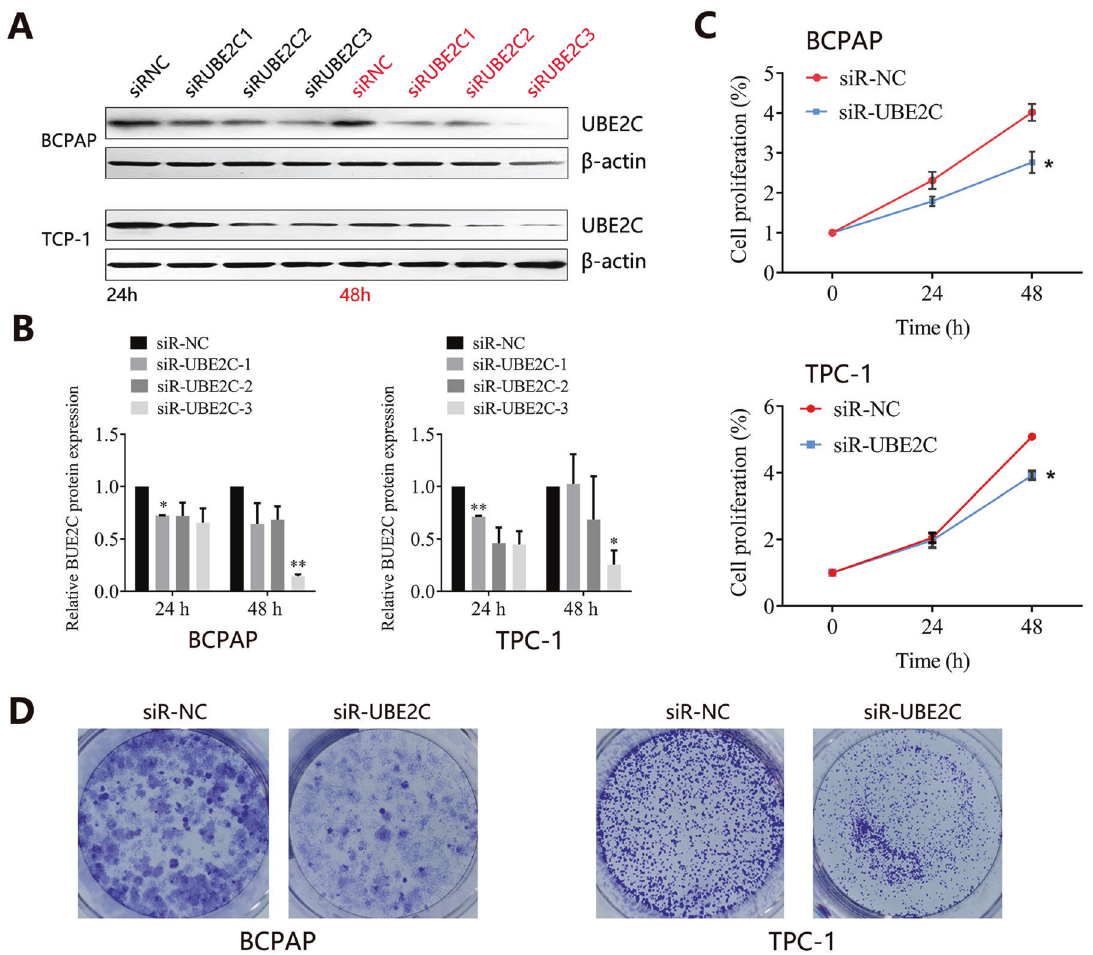
Fig. 4 The knockdown treatment of UBE2C in THCA cell lines. A Knockdown ef fi ciency determination by western blot. B Quantity analysis on UBE2C protein expression with UBE2C knockdown. C Effect of UBE2C knockdown with optimal siR-UBE2C-3 on THCA cell growth. D Colonies of THCA cells with siR-UBE2C-3 knockdown treatment. UBE2C ubiquitin-conjugating enzyme E2 C, THCA thyroid